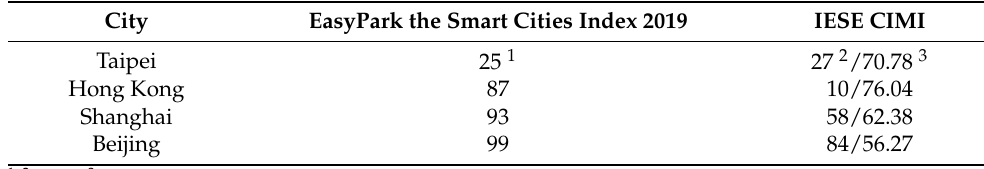
Table 1. Ranking of major smart cities in